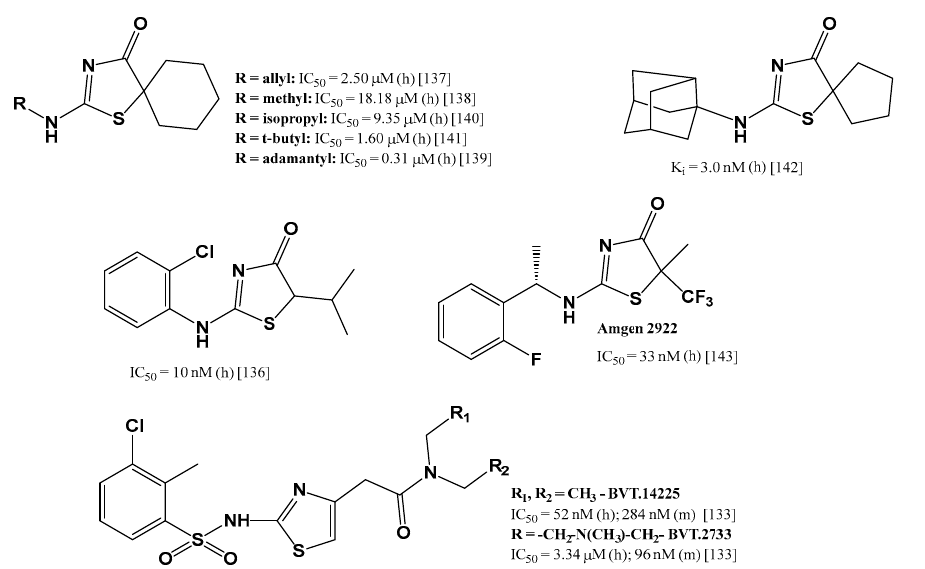
Figure 5. Selected selective 11 β -HSD1 inhibitors with thiazole and thiazol-4-one moiety in in vitro studies. Data refer to tests for human (h) or murine (m) 11 β -HSD1 [133,137–143]. KR-67183 (R 1 = H, R 2 = Cl) IC 50 = 1.0 nM (h); 4.0 nM (m) [154,155]